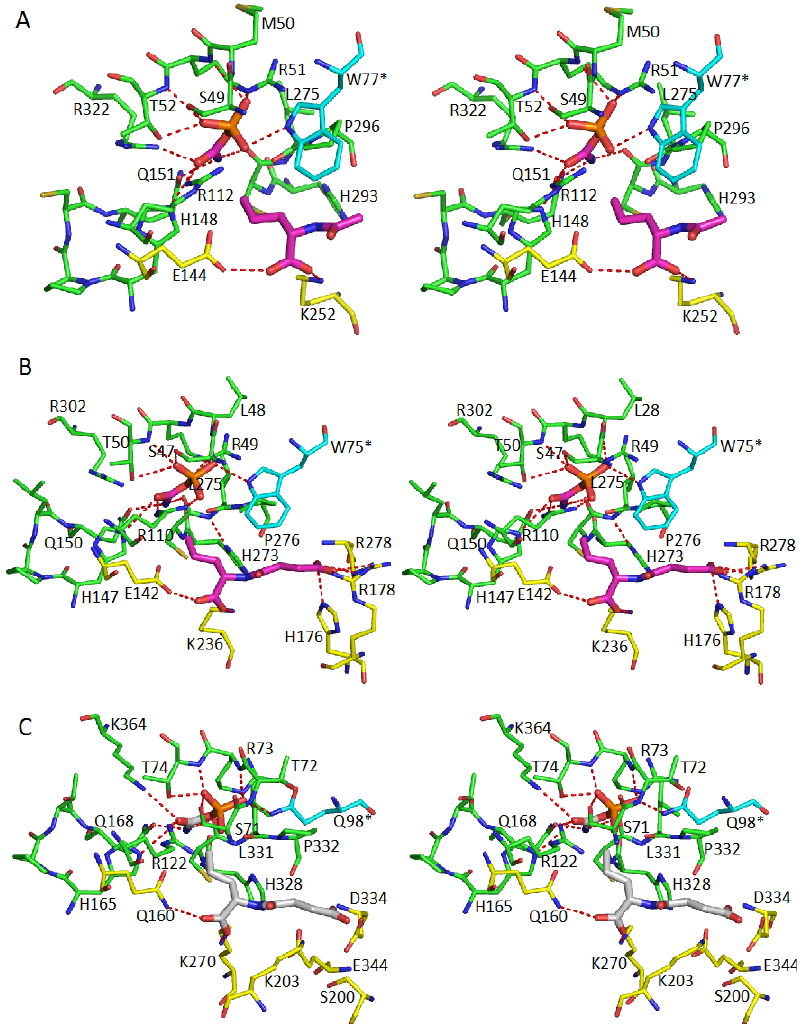
Figure 7. Stereo diagrams of the active sites of Xanthomonas campestris AOTCase ( A ); Bacteroides fragilis SOTCase ( B ); and Escherichia coli YTCase ( C ). The residues involved in binding CP are shown as green sticks. The residues involved in binding the second substrate are indicated by yellow sticks. The residues from the adjacent subunit are indicated by cyan sticks. The bound substrates or inhibitor are shown as thick magenta sticks. The residues in the original model (PDB code 3Q98) that are missing in YTCase were modeled based on OTCase Vibrio vulnificus (PDB code 4H31) and Enterococus faecalis YTCase (2YFK) using the IntFold server [69]. The CP and N -succinyl- L -norvaline in YTCase shown as grey sticks are not in the original model, but indicate the possible substrate binding site. The oxygen and nitrogen atoms are shown in red and blue sticks, respectively. The potential hydrogen bonding interactions are indicated by red dotted